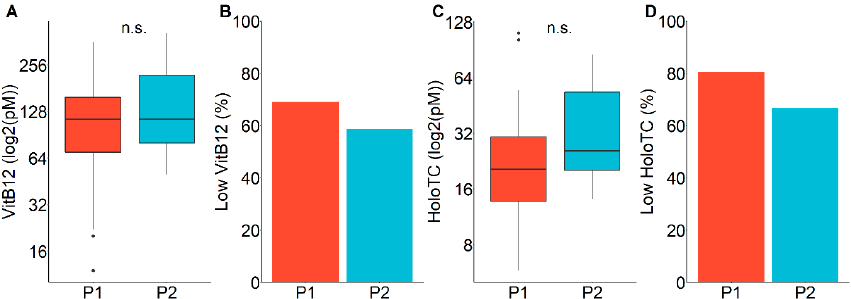
Figure 3. Evaluation of screening-positives by clinical laboratory parameters. ( A ) Serum vitamin B12 (VitB12) concentrations of screening-positives. n = 42 and 17, for period 1 and 2, respectively. ( B ) Positive predictive value for low VitB12. The graph shows the percentages of newborns being below the cuto ff for low ( < 148 pM) out of 42 and 17, for period 1 and 2, respectively, screening positives with reported VitB12 concentrations. ( C ) Serum holotranscobalamin (holoTC) concentrations of screening-positives. n = 31 and 12, for period 1 and 2, respectively. ( D ) Positive predictive value of the screening algorithm for low holoTC. The graph shows the percentages of newborns being below the cut-o ff ( < 35 µ M) out of = 31 and 12, for period 1 and 2, respectively, screening-positives with reported concentrations. Red bars show values for the first screening period, blue bars for period 2; P1, first period; P2, second period of screening.